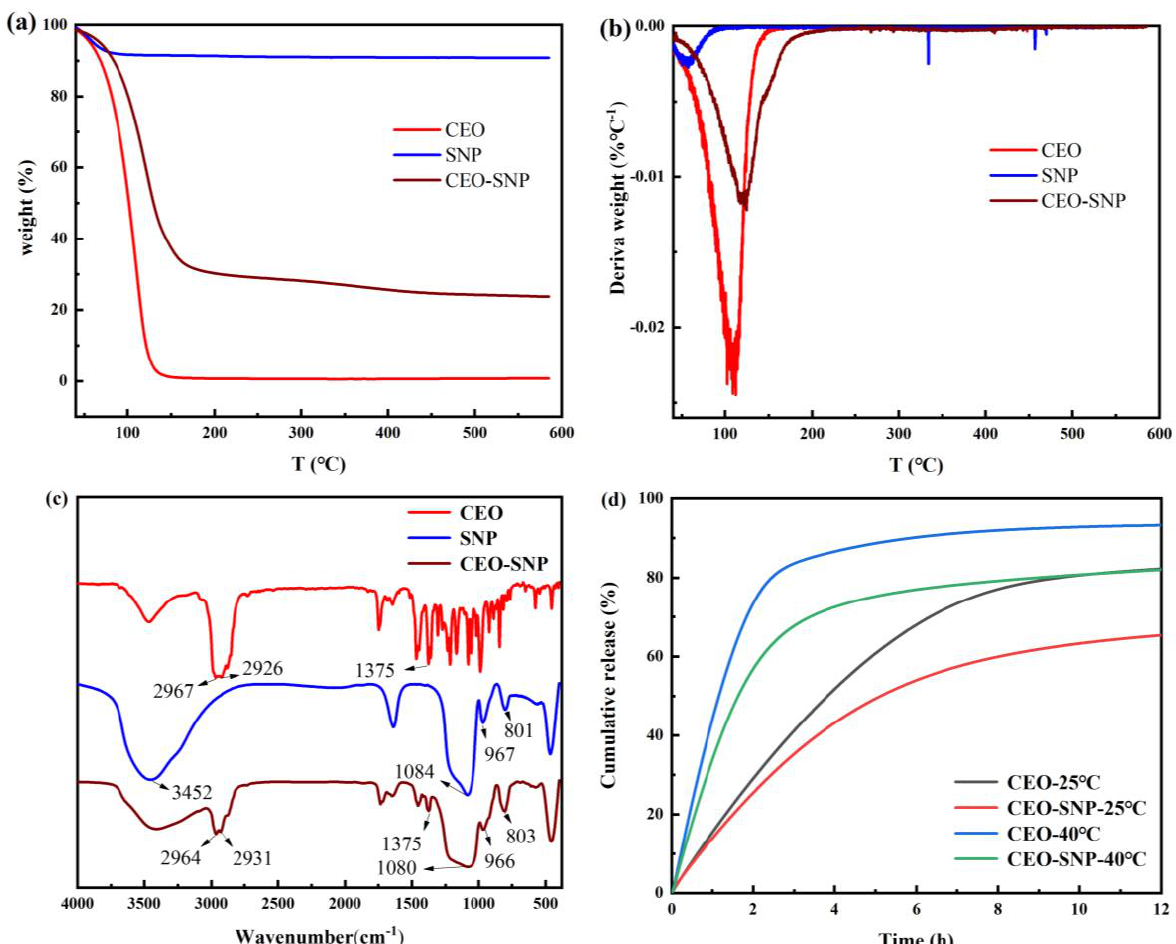
Figure 4. The TGA ( a ) and DTG ( b ) curves and FTIR spectra ( c ) of CEO, SNP and CEO-SNP. Drug release curves ( d ) of CEO and CEO-SNP at 25 and 40 °C.